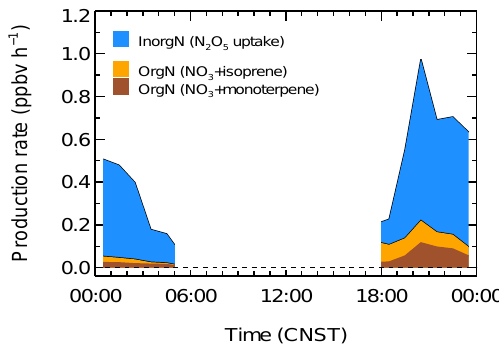
Figure 9. The nighttime production rate of organic and inorganic nitrates; the inorganic nitrates were calculated from N 2 O 5 hetero- geneous hydrolysis, and ONs were calculated with the NO 3 reacted with isoprene and